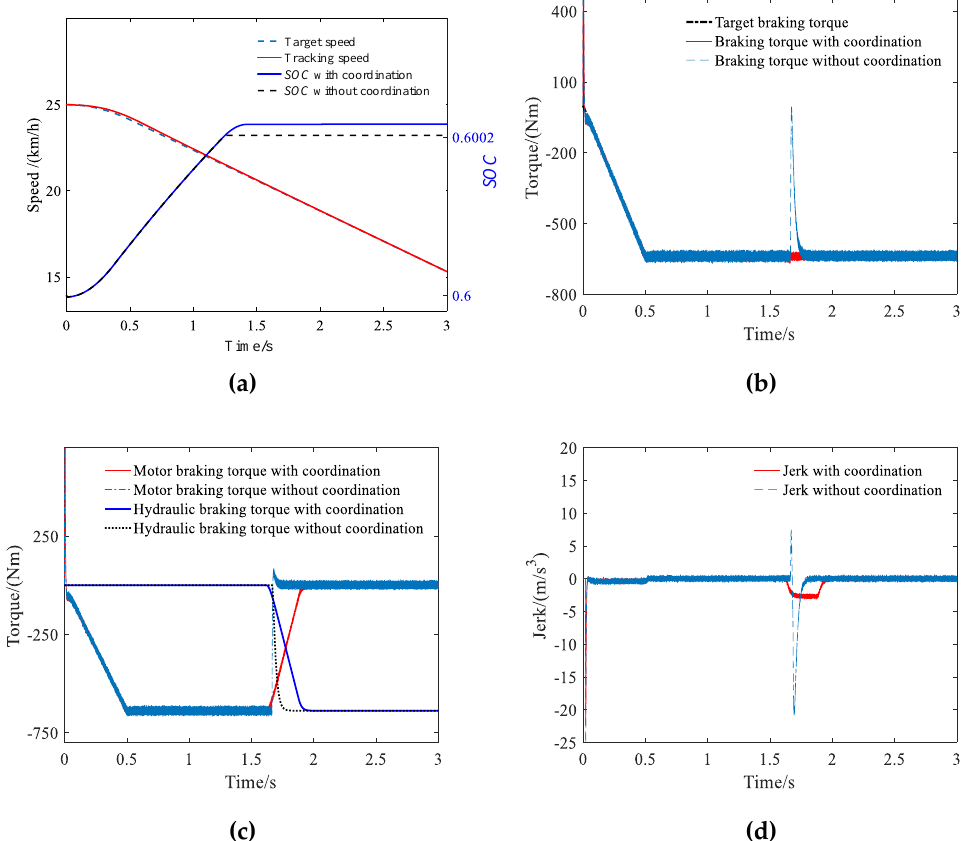
Figure 14. Simulation results of the pure hydraulic switch to a pure motor braking mode under a constant braking strength: ( a ) The variation in vehicle speed and SOC , ( b ) the variation in total braking torque, ( c ) the variation in motor and hydraulic braking torque, and ( d ) the variation in vehicle jerk.